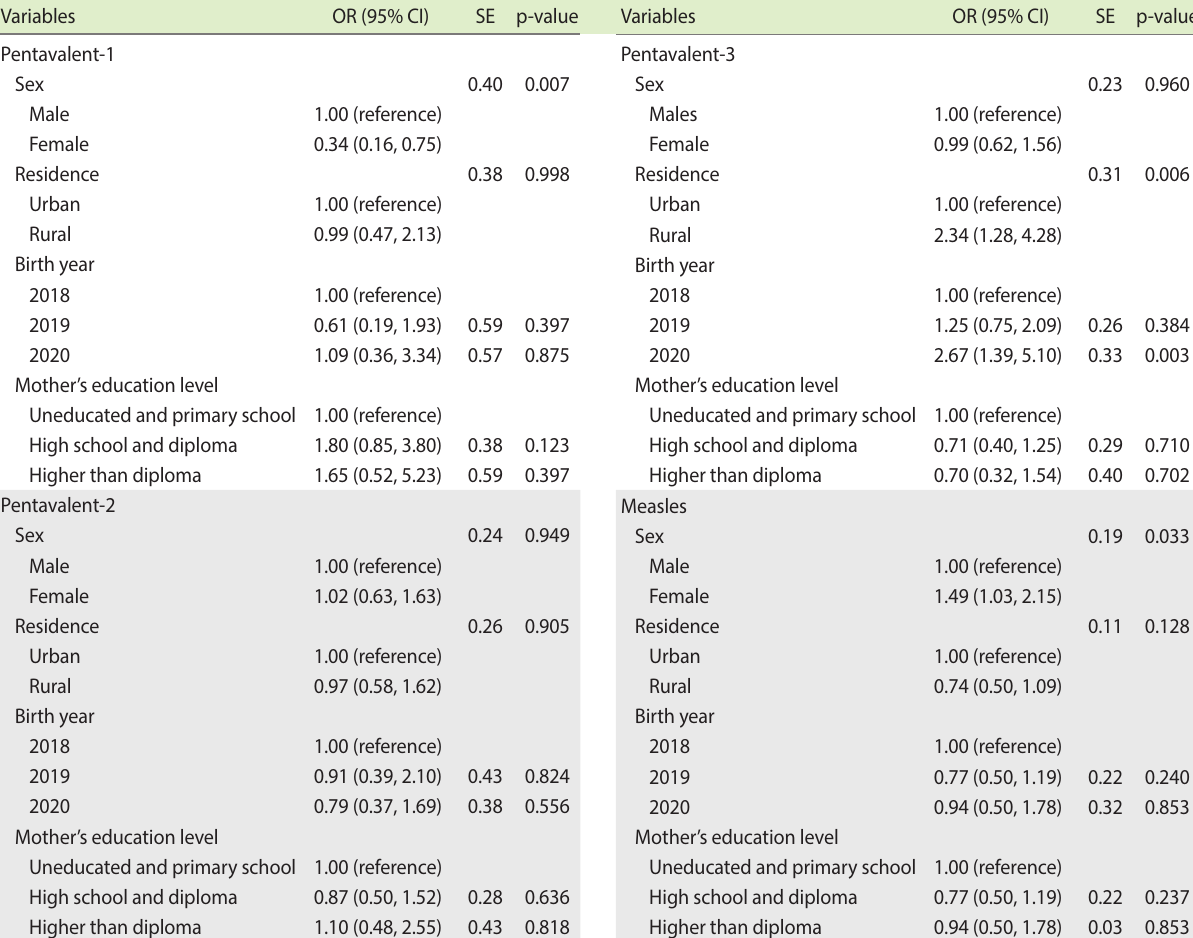
Table 3. Associations between receiving a vaccine and potential predictors